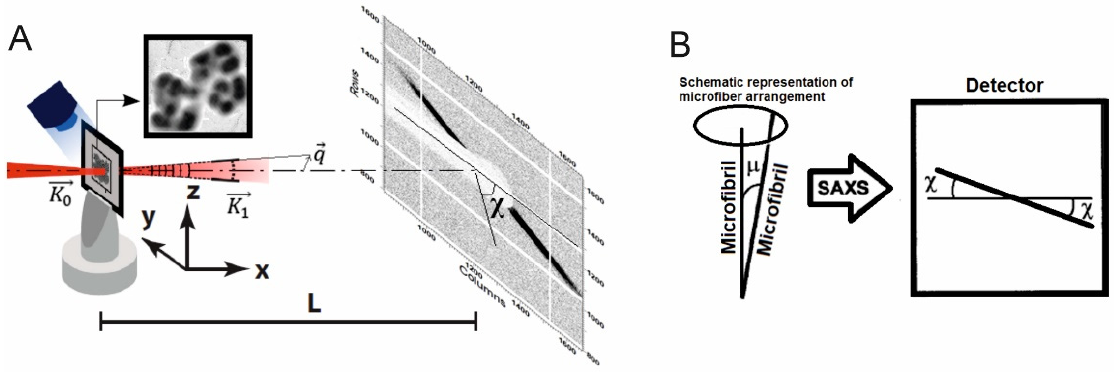
→ K 1 ¯ a wave (cid:4652)(cid:4652)(cid:4652)(cid:4652)⃗— a